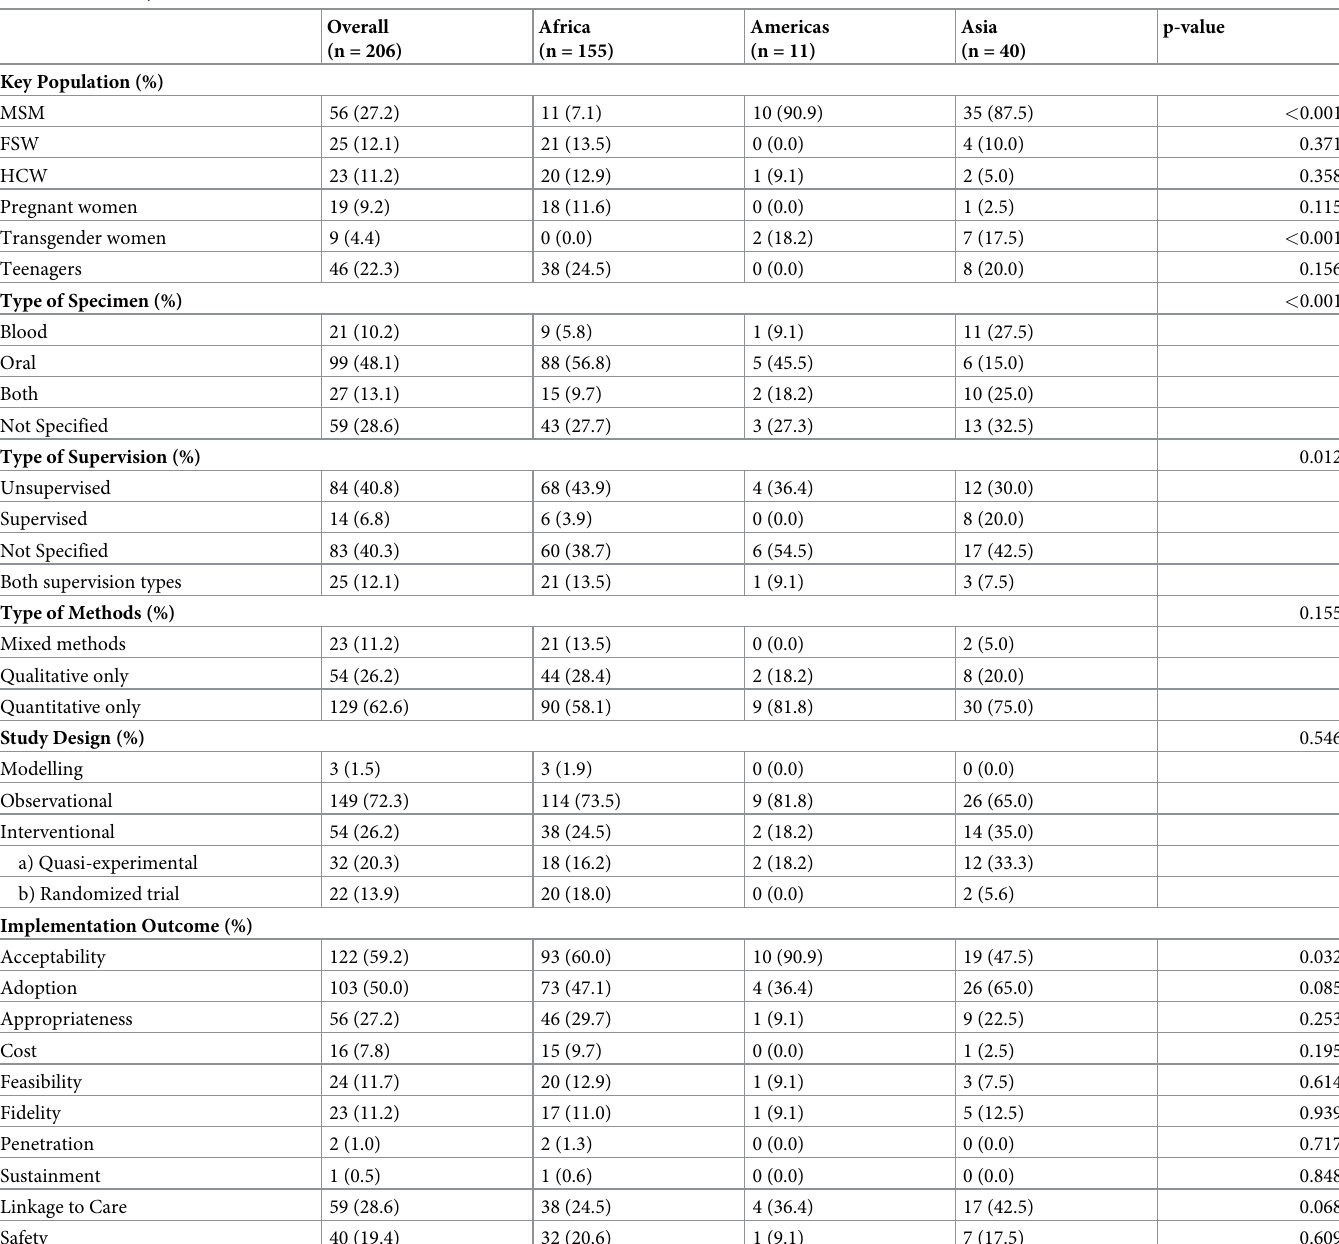
Table 1. Summary characteristics of included